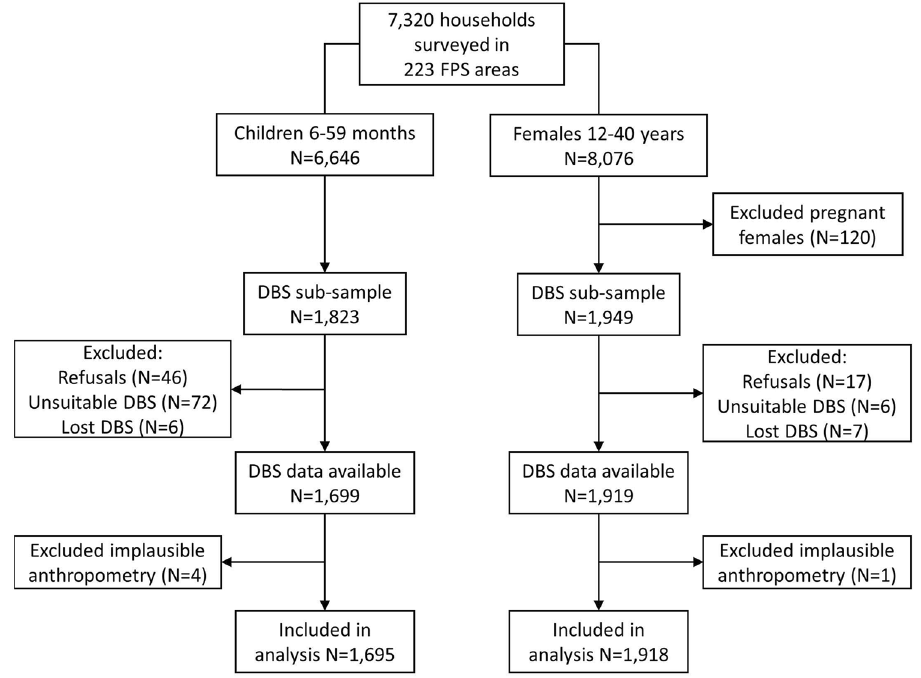
Figure 1. Sample selection flowchart for analysis of HemoCue and DBS Hb measurement